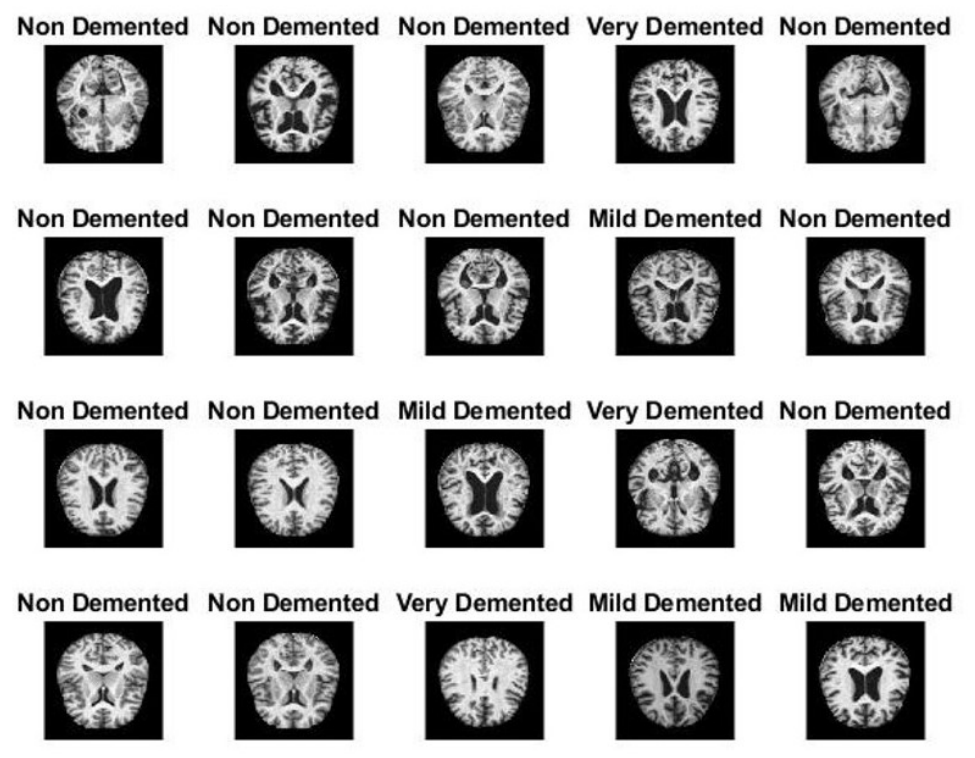
Figure 3. Sample MRI images after the image enhancement